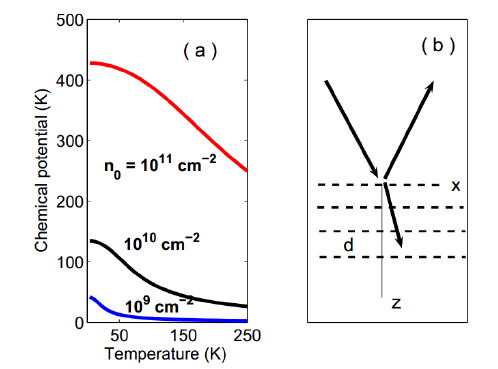
Figure 2. Observation of chemical potential and wave scattering. ( a ) a ration of chemical potential and temperature; ( b ) wave scattering using multiple layers. Reprinted with permission from